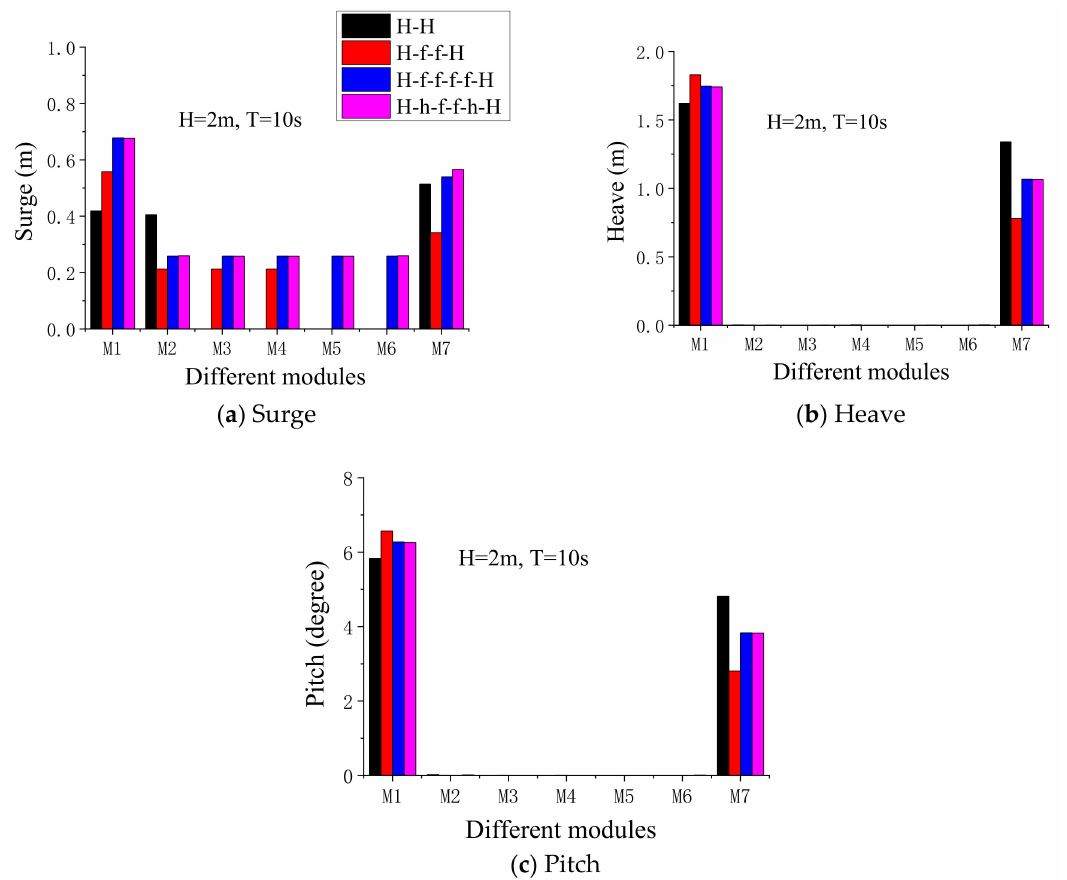
Figure 11. Comparison of main motion responses of the MTLPW system with different number of inner tension-leg platforms (TLP) modules: ( a ) Surge, ( b ) heave, ( c )